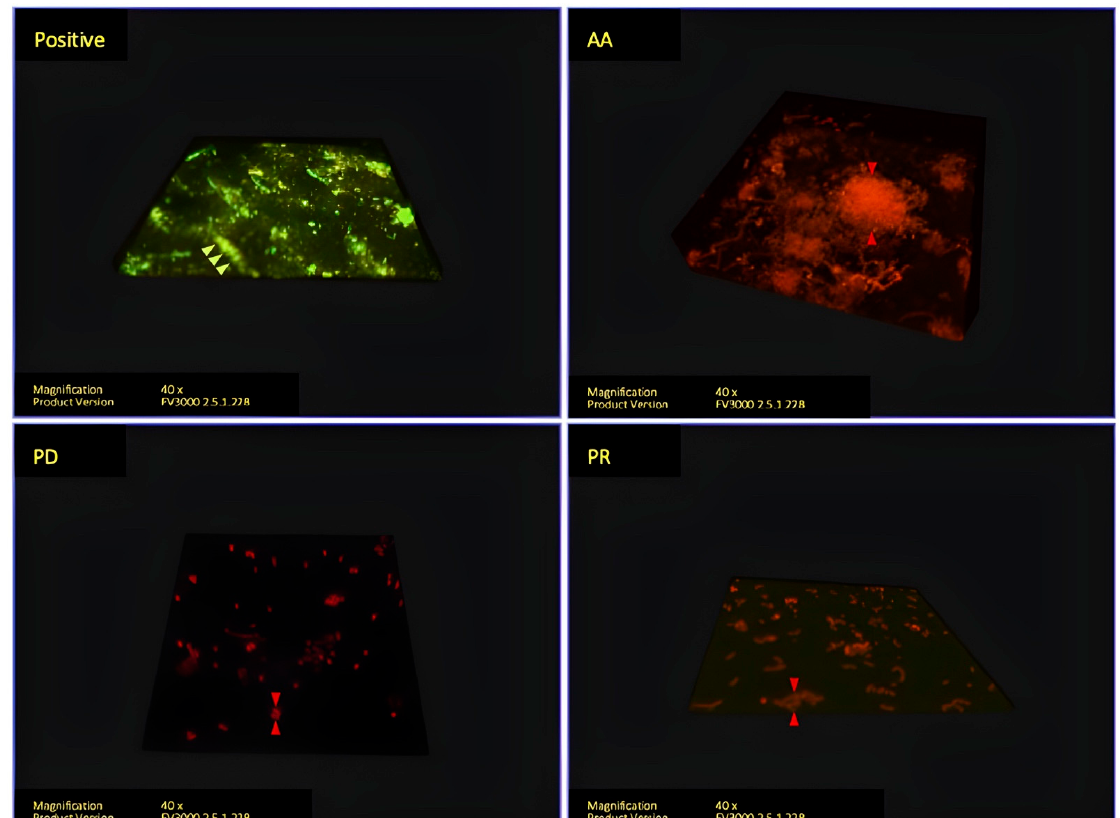
Figure 4. Vivera ® retainer 3D imaging analyzed with confocal microscope. Living cells stained with SYTO9 are indicated with green arrows. Dead cells stained with PI are indicated with red arrows.